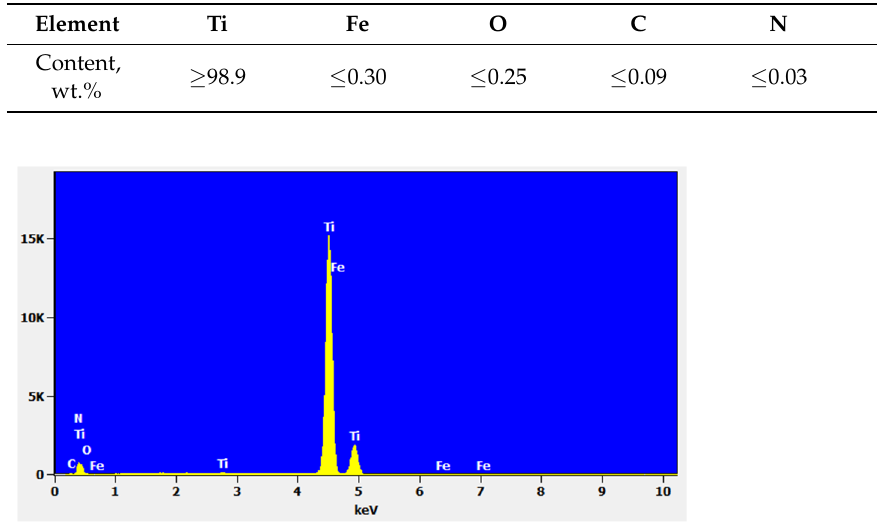
Figure 2. EDS spectrum of Grade 2 CP titanium.